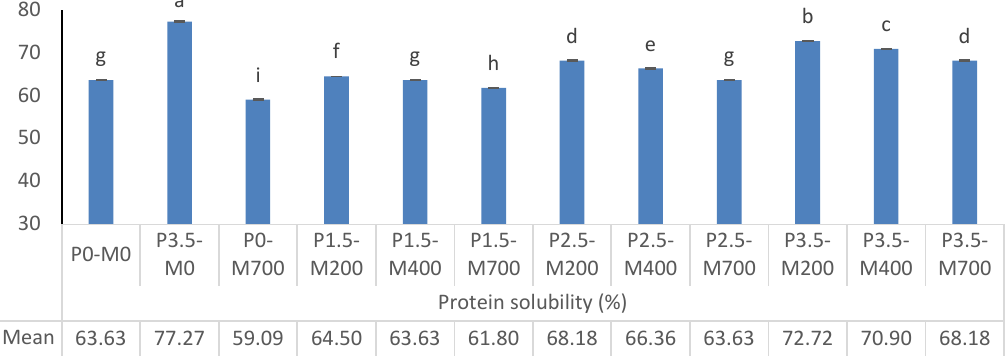
Figure 1. The effect of phosphorylation (%) and microwave power (W) on protein solubility of egg white powder. Means ( n = 3) with different letters in each column indicate significant difference ( p < 0.05).